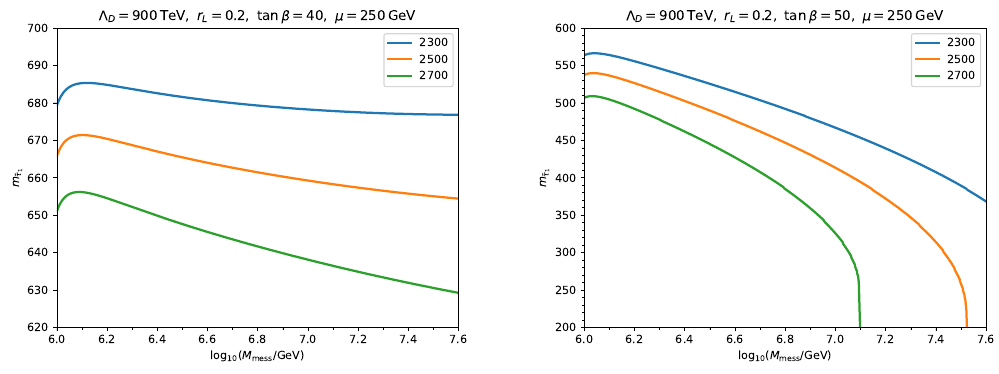
Figure 2 . The lightest stau mass as a function of the messenger scale for different m A , m A = (2300 , 2500 , 2700) GeV. In the left (right) panel, tan β = 40 (50).